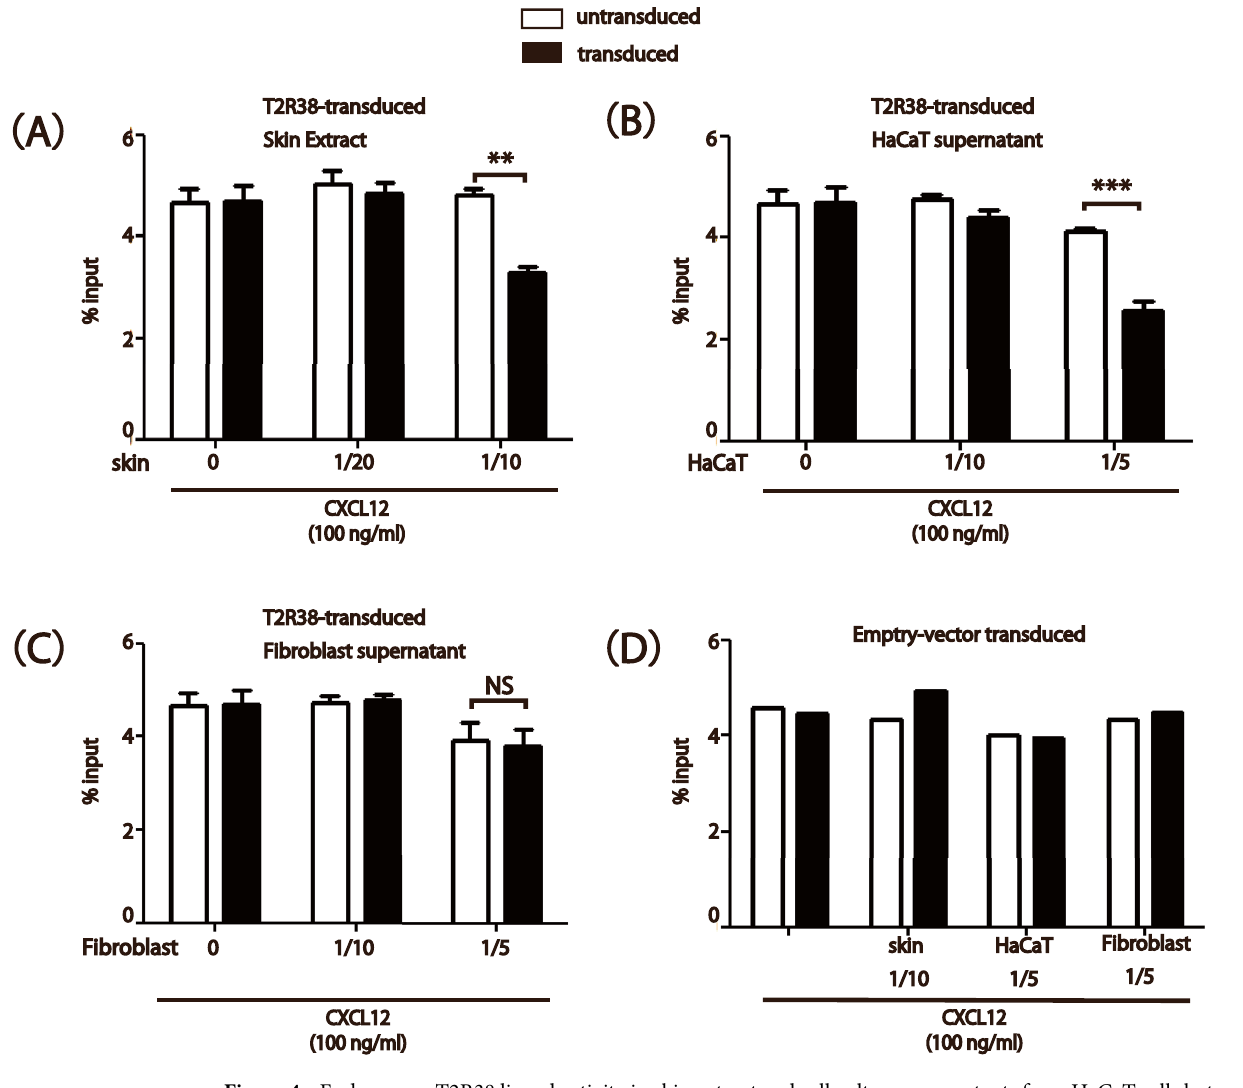
Figure 4. Endogenous T2R38 ligand activity in skin extract and cell culture supernatants from HaCaT cells but not from fibroblasts. ( A – C ) Migration of T2R38 transduced Jurkat cells to recombinant human CXC chemokine ligand 12 (CXCL12) and the indicated amounts of diluted skin extract ( A ), HaCaT cell culture supernatants ( B ), or fibroblast cell culture supernatants ( C ). ( D ) Migration of empty vector-transduced Jurkat cells. Skin extract and cell culture supernatants were mixed with CXCL12 (100 ng/ml). The white bars indicate untransduced cells, and black bars indicate transduced cells. One representative of three independent experiments is shown. ( A – C ) n = 3; ( D ) n = 2. *** P < 0.001, ** P < 0.01 by Student’s t